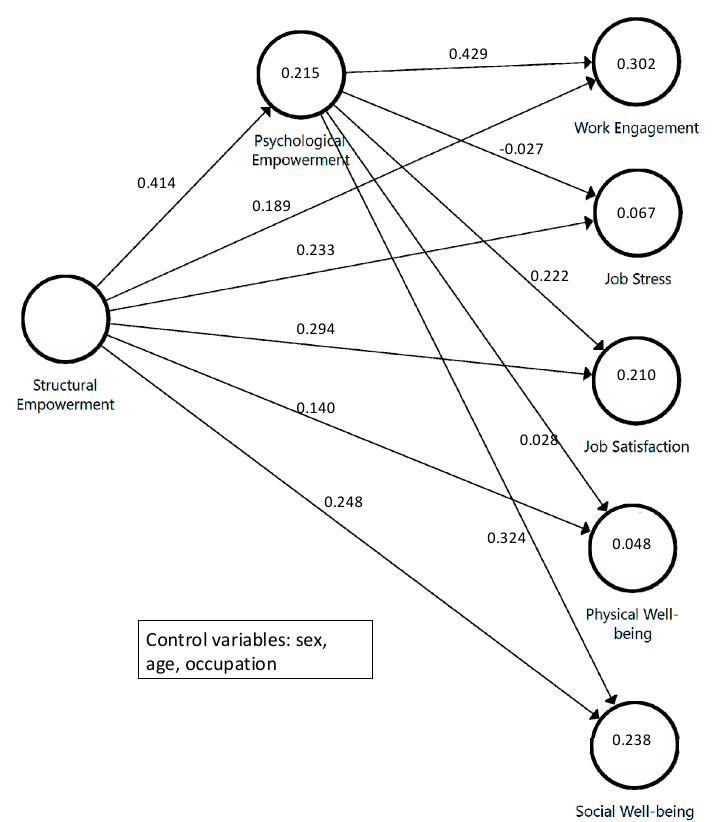
Figure 1. Simplified model representation. Values inside circles are R2. All paths are statistically significant. H3 was tested comparing direct paths from SE to well-being variables with the corre- sponding indirect paths (H1xH2a; H1xH2b and H1xH2c).